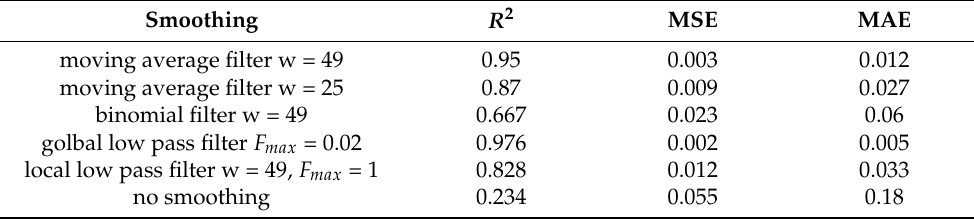
Table 8. The impact of data preprocessing on prediction accuracy for Decision Tree Regression. Smoothing